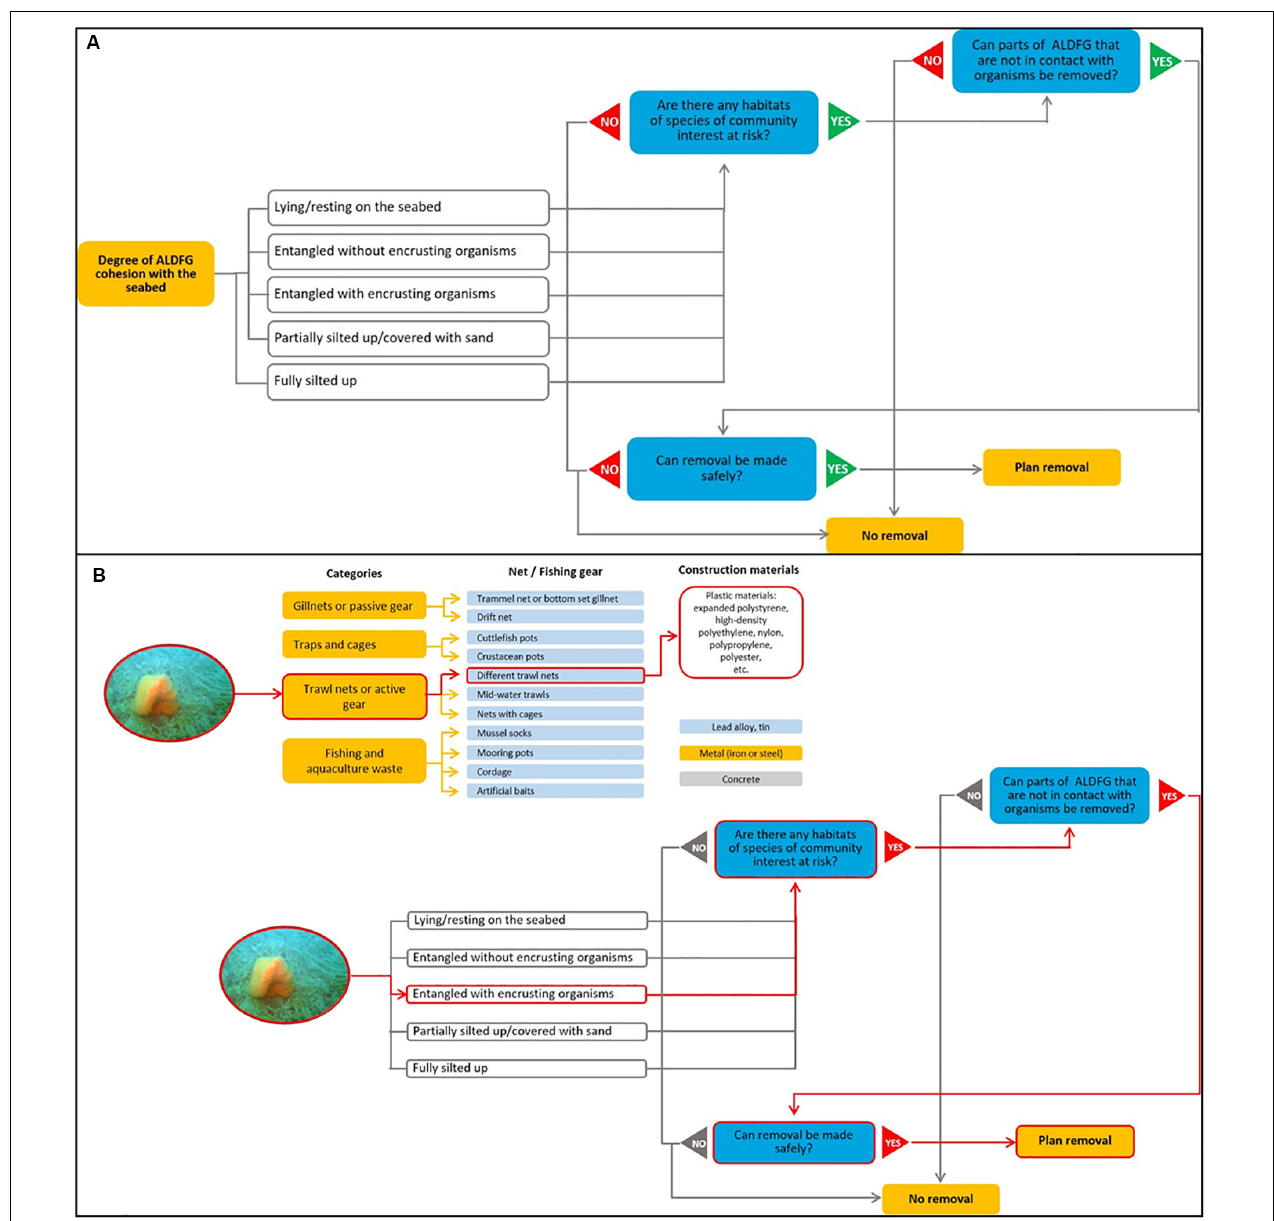
FIGURE 3 | (A) Decision flowchart for assessing the degree of entanglement and removability of ALDFG detected on the seabed. (B) Example of application with a bottom trawl to be removed, on which encrusting organism had grown (from Da Ros et al.,